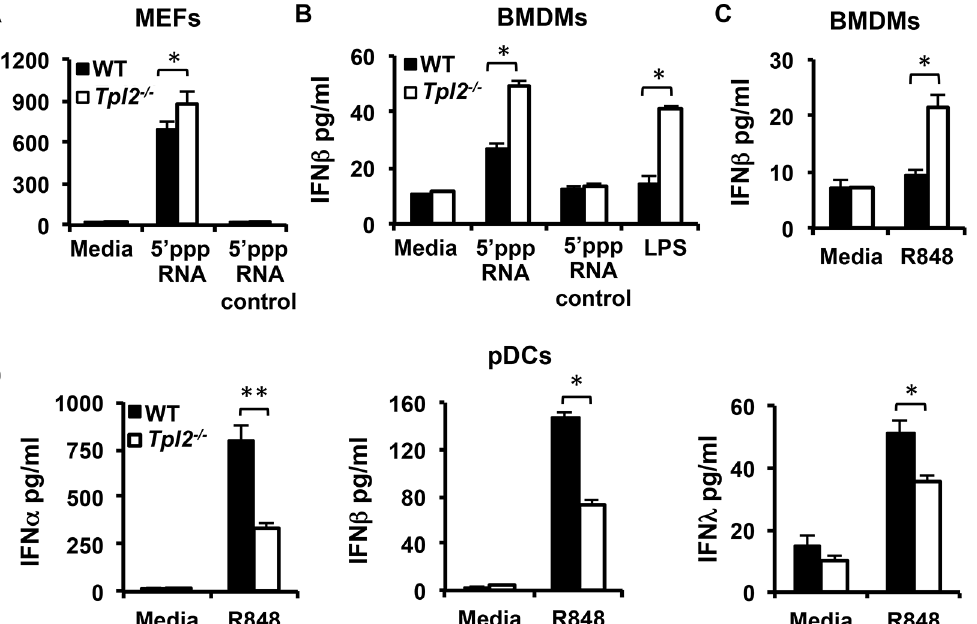
Fig 3. Tpl2 differentially regulates IFN production in response to model viral ligands in a cell type-specific manner. MEFs (A) or BMDMs (B-C) from WT and Tpl2 -/- mice were transfected with 5 ’ ppp-RNA or stimulated R848 or LPS for 24 hr, and IFN β levels were measured by ELISA. (D) Plasmacytoid DCs were stimulated with R848 for 24 hr, and IFN α , β and λ levels were measured. Data are representative of 3 – 4 independent experiments. Graphs show means ± SD. * indicates p < 0.05, ** indicates p < 0.01.